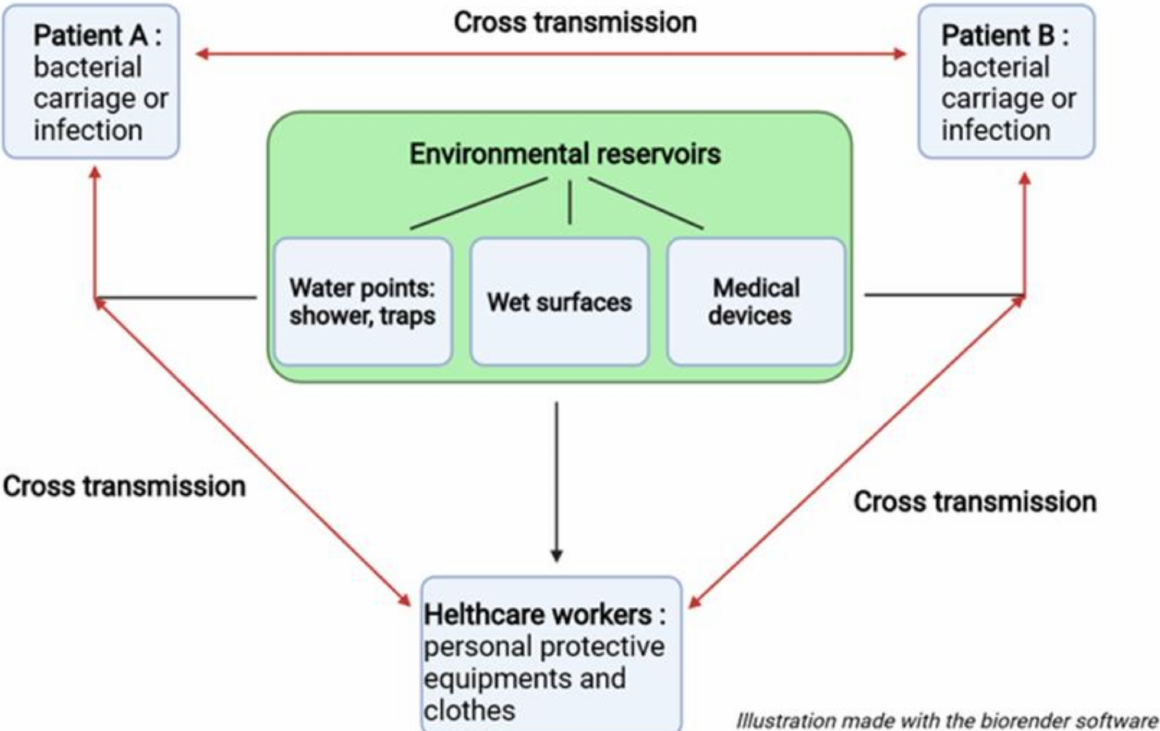
Figure 3. Epidemiological cycle of P. aeruginosa in the hospital